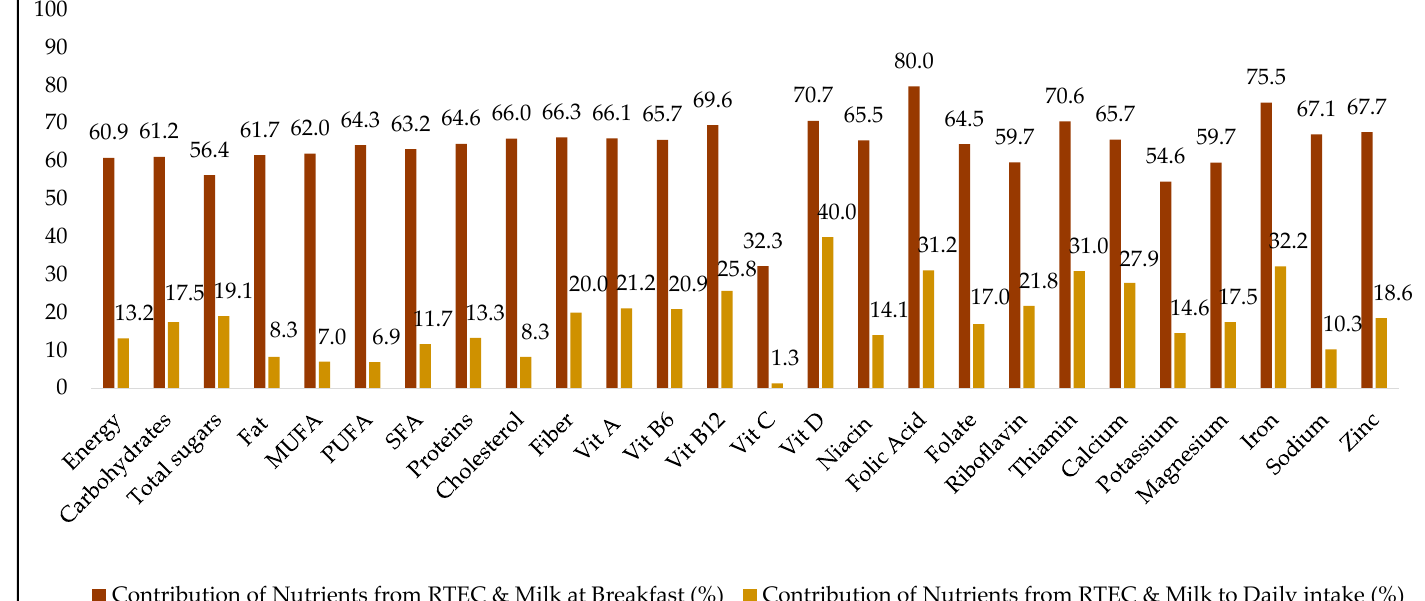
Figure 2. Contribution (%) of ready to eat cereal (RTEC) and milk to nutrient intake at breakfast and daily among all Canadians. 1. All data are weighted and bootstrapped to obtain estimates at the Canadian population level. Data source: 2015 Canadian Community Health Survey-Nutrition. Co-consumption was determined when the period reported for consumption of ready-to-eat cereal and milk was the same. MUFA: monounsaturated fatty acids, PUFA: polyunsaturated fatty acids, SFA: saturated fatty acids, Vit: vitamin.